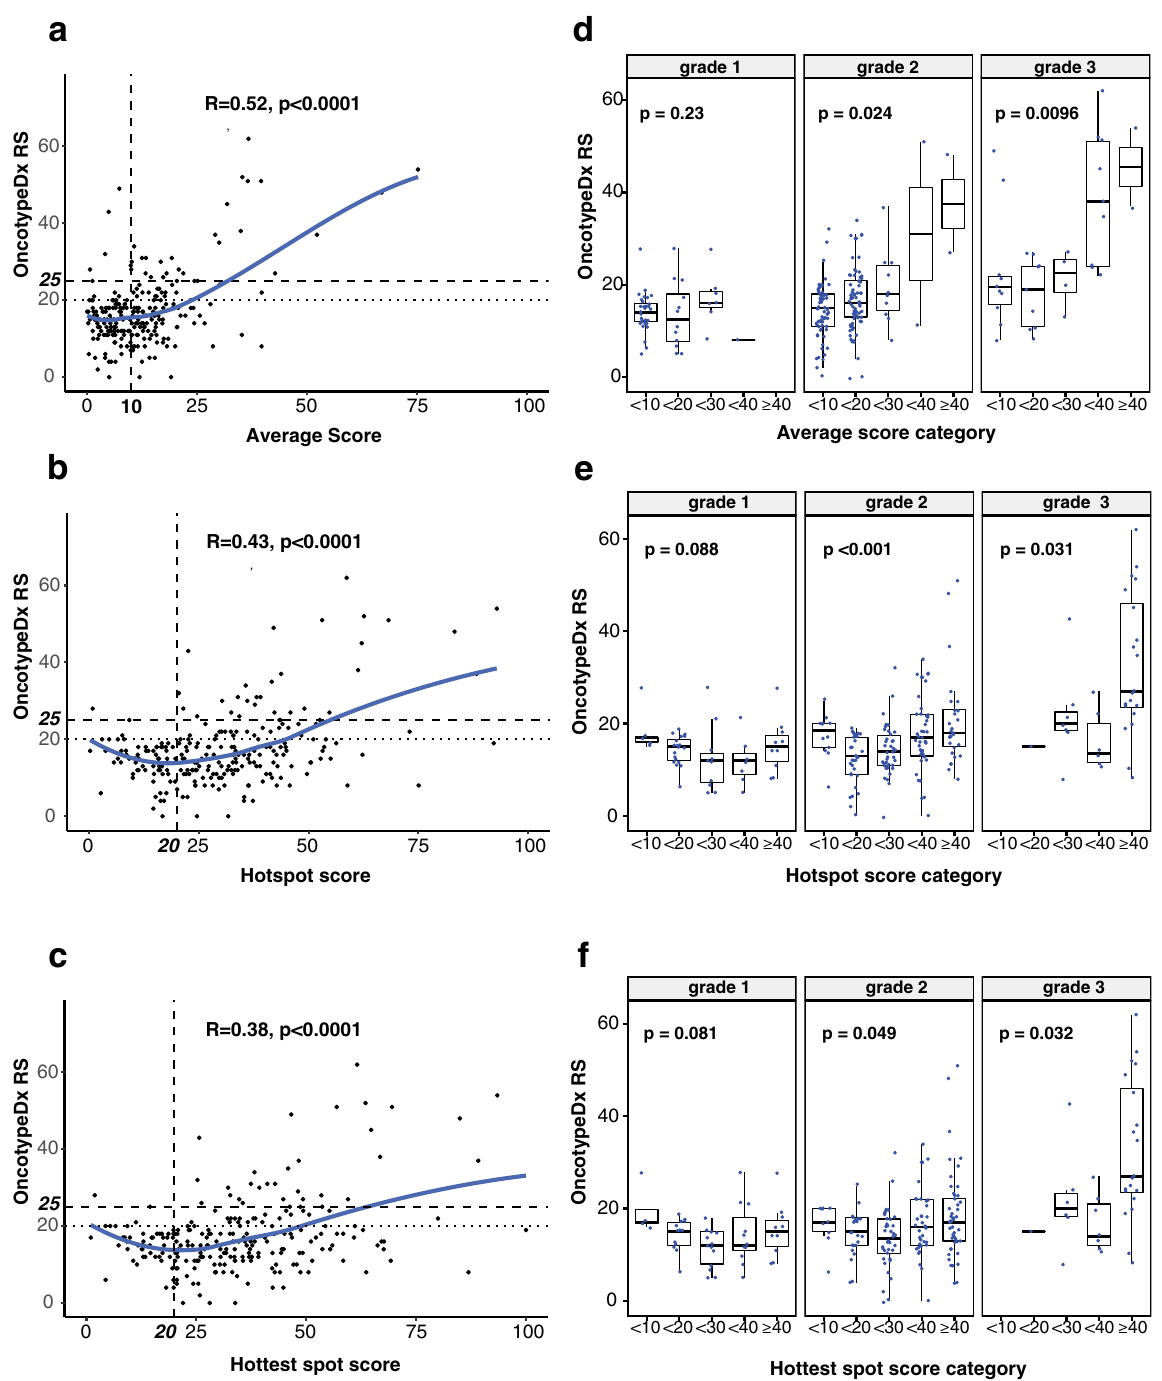
Fig. 2 Correlation between 21-gene recurrence score (RS) and Ki67 labeling indexes as continuous and categorical variables. a Correlation between Ki67 average score as a continuous variable and OncotypeDx Recurrence Score (RS). Solid line represent loess smoothing fi t of the data. Relevant cut points are shown as broken lines with bold legends in each axis. R = Pearson correlation coef fi cient. b Correlation between Ki67 hotspot score as a continuous variable and OncotypeDx RS. c Correlation between Ki67 hottest spot score as a continuous variable and OncotypeDx RS. d Correlation between Ki67 average score as a categorical variable and OncotypeDx RS within each histological grade. Box plot is drawn as follows; each box represents interquartile range with the inside line representing the median value. Whiskers represent maximum (75th percentile + 1.5 × interquartile range) and minimum (25th percentile – 1.5 × interquartile range) values. Each dot represents individual samples. P value is from Kruskal – Wallis test. e Correlation between Ki67 hotspot score as a categorical variable and OncotypeDx RS within each histological grade. f Correlation between Ki67 hottest spot score as categorical variable and OncotypeDx RS within each histological